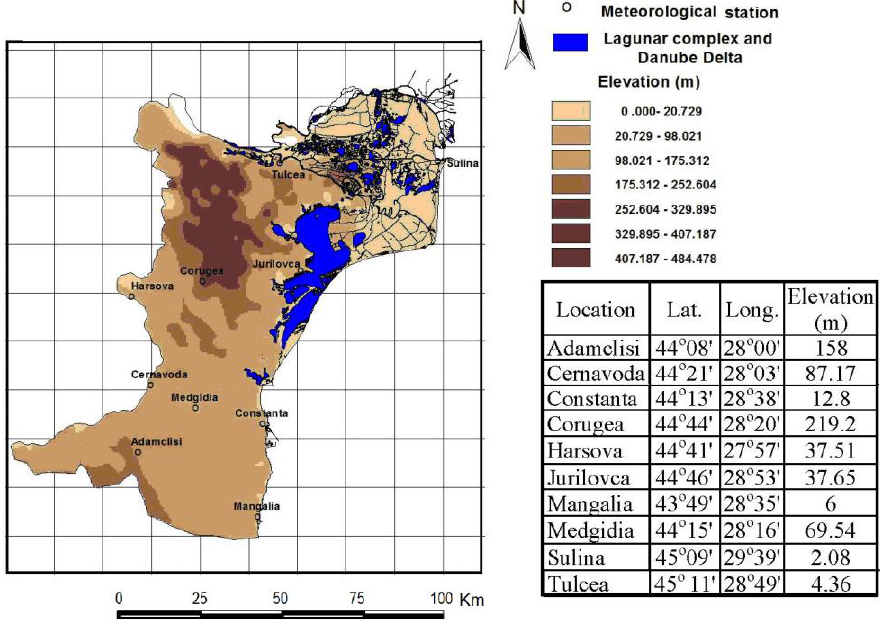
Figure 6. Dobrogea region and the meteorological stations.